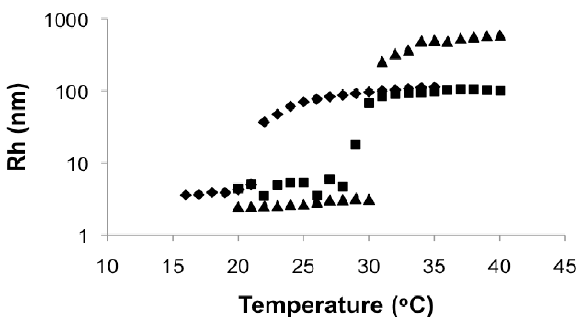
) as a function of temperature of block h = 90 mol%, M = 27.8 kg mol − 1 , (cid:139) ), DMAEMA,overall n = 89 DMAEMA